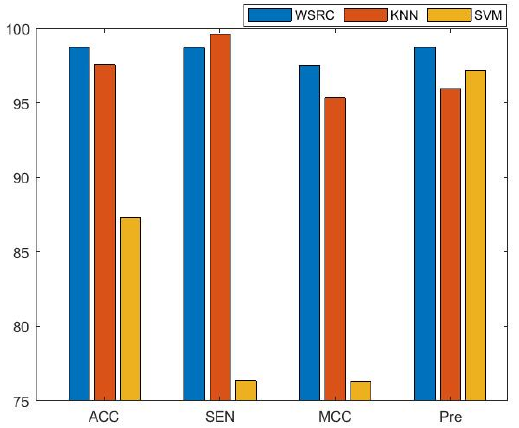
Figure 1. The performance comparisons of different classifiers. WSRC: weighted sparse representation-based classification; KNN: K-nearest neighbors; SVM: support vector machine.